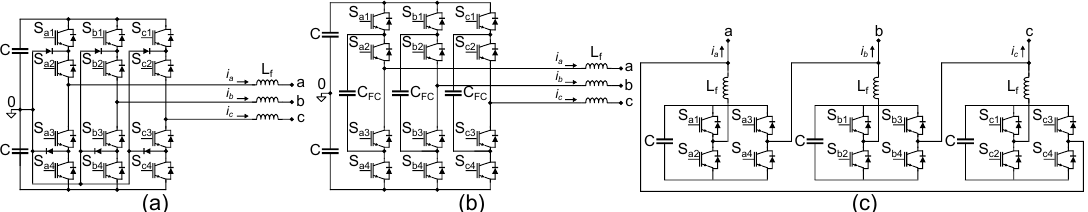
Figure 7. Main topologies of multilevel three-wire APFs: ( a ) neutral-point-clamped (NPC) converter; ( b ) flying capacitor (FC) converter; ( c ) cascaded H-bridge (CHB) converter.